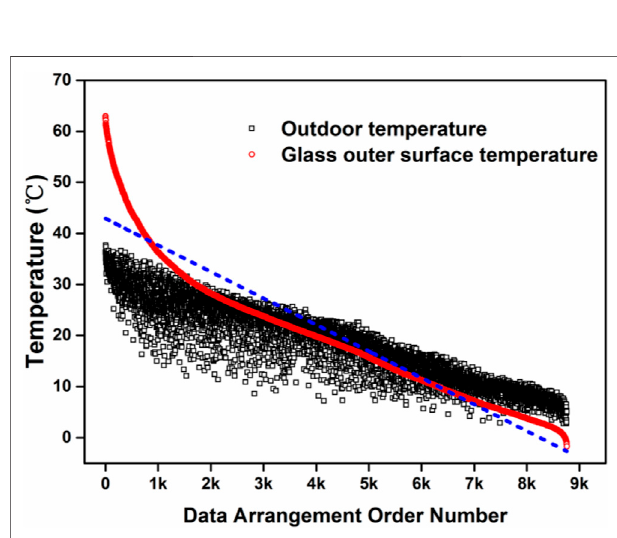
FIGURE 5 | Temperature distribution of skylight outer surface and outdoor air temperature in Chongqing area in natural ventilation condition.